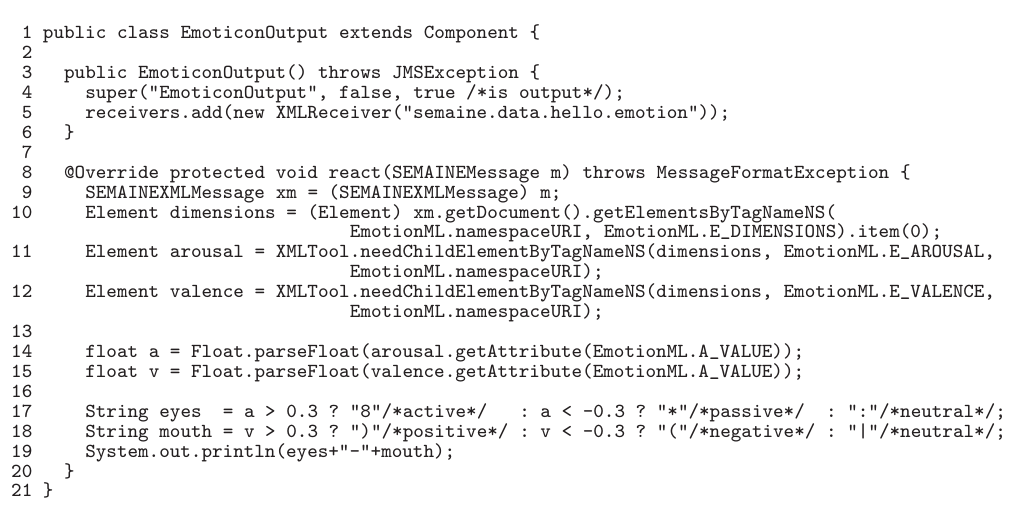
Figure 14: The EmoticonOutput component. It receives EmotionML markup and displays an emoticon according to Table 3.